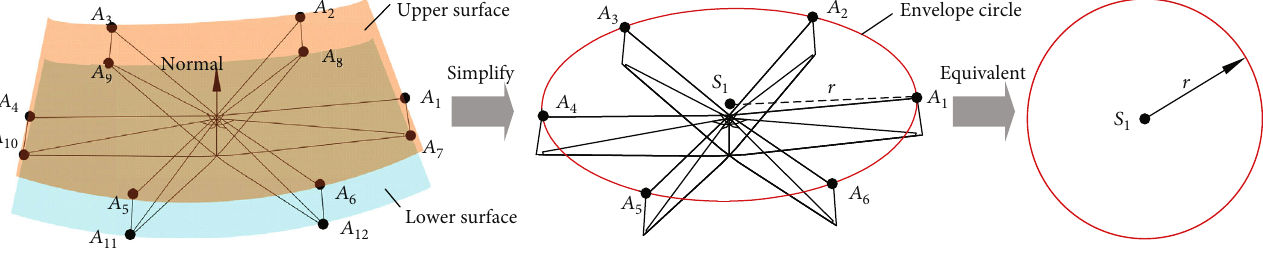
Figure 9: Envelope circle equivalent process.